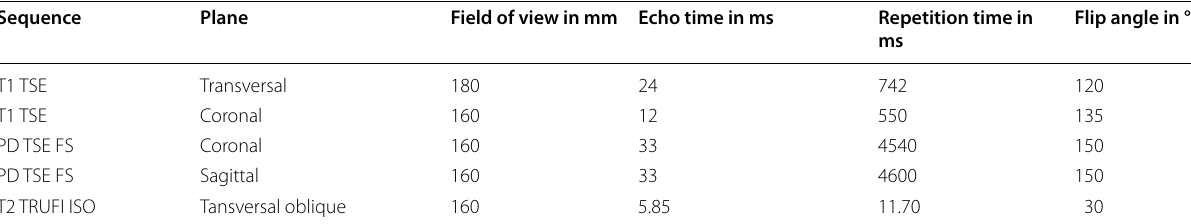
mm millimeters, ms milliseconds, TSE turbo spin-echo, FS fat-suppressed, PD proton density, TRUFI true fast imaging with steady-state free precession